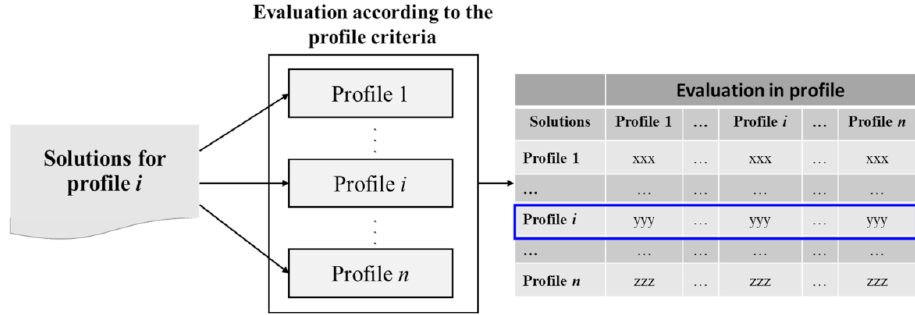
Figure 8. Evaluation of the profile according to the profile criteria.